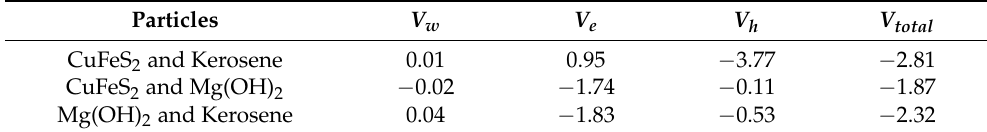
Table 2. The interaction energies (10 − 7 J) among chalcopyrite, kerosene, and Mg(OH) 2 at a distance of 2 nm. Particles V w V